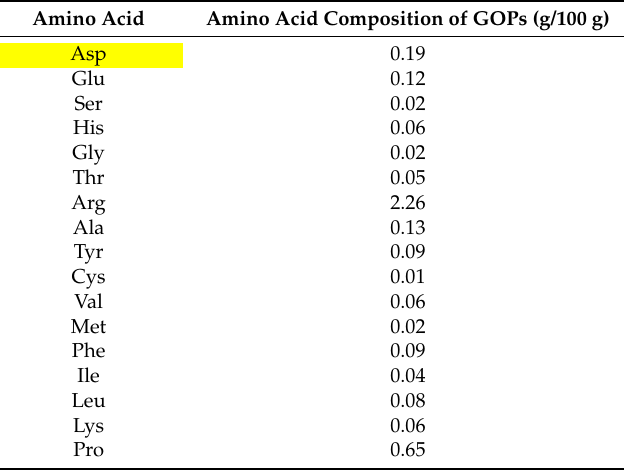
Table 1. Amino acid composition of ginseng oligopeptides (GOPs). Amino Acid Amino Acid Composition of GOPs (g/100